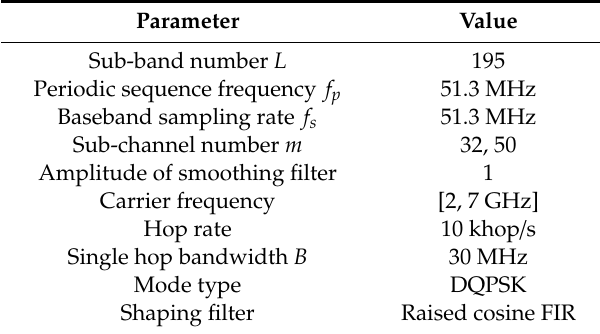
Table 1. Simulation